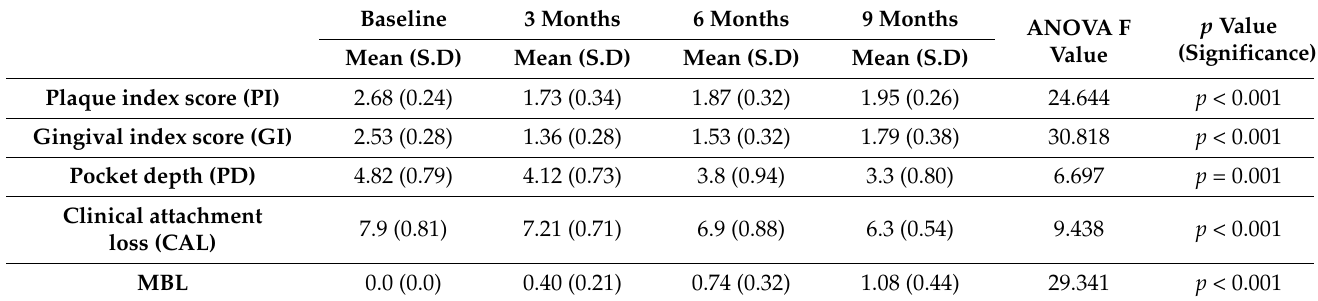
Table 3. Intragroup comparison of clinical parameters in control group.